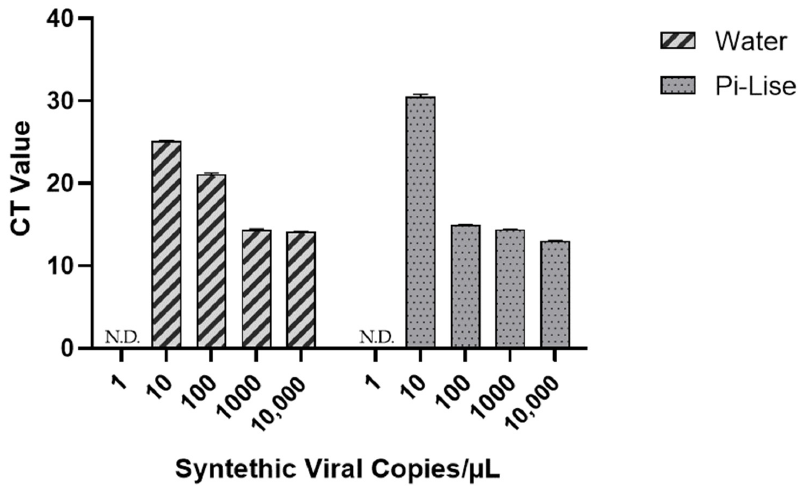
Figure 4. RT-qPCR of synthetic SARS-CoV-2 RNA control diluted in water or 50:50 H 2 O:Pi-Lise mixture. “N.D.” means not detected.